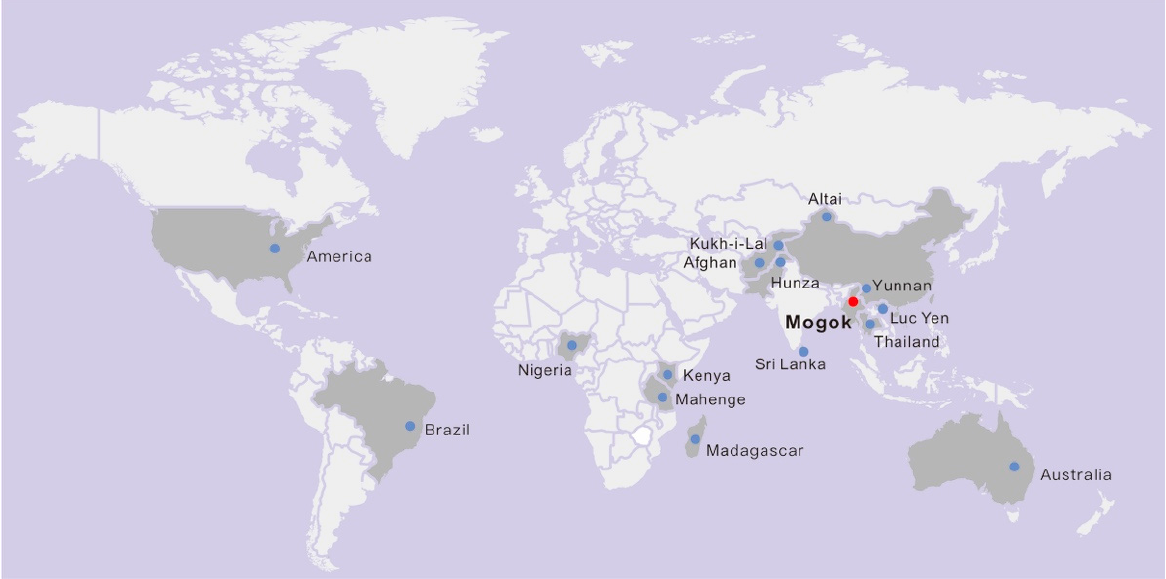
Figure 1. Map of the global gem-grade spinel-producing areas (grey parts). The gray shaded area is the country of gem spinel origin. The red dot locates Mogok, Myanmar.